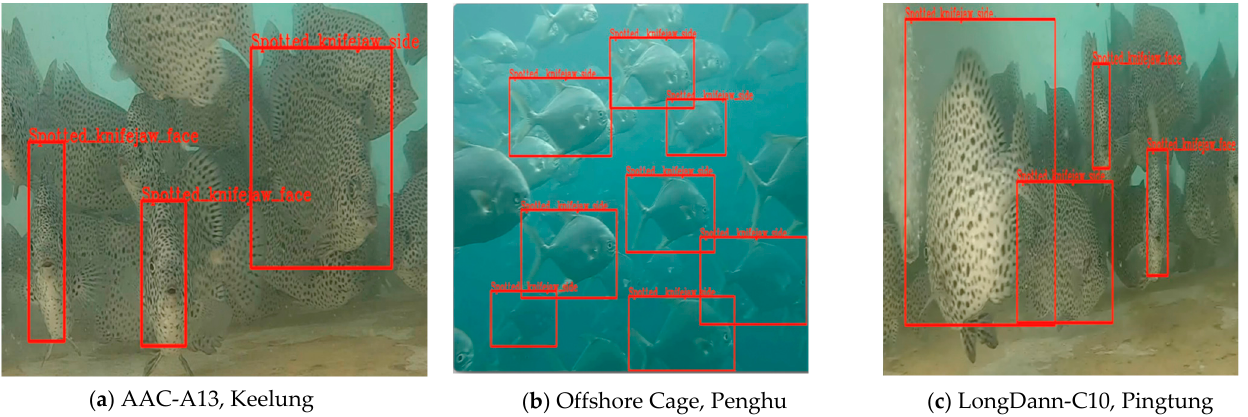
Figure 26. Fish target object detection results using YOLOv4 in the different aquaculture sites.